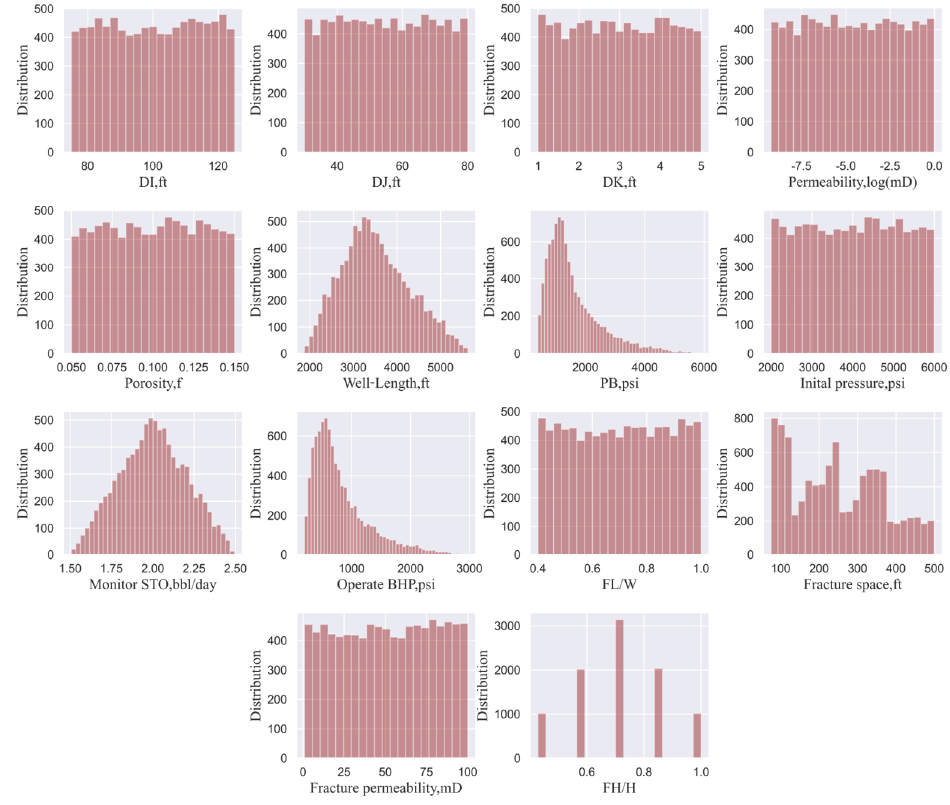
Figure 8. Histograms of reservoir and fracturing parameters.